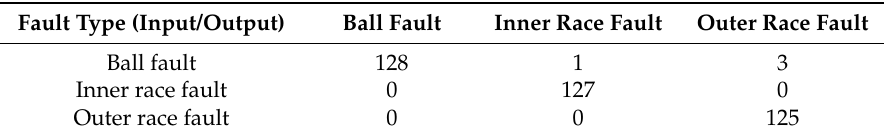
Table 5. Statistical performances, segments of the testing set.